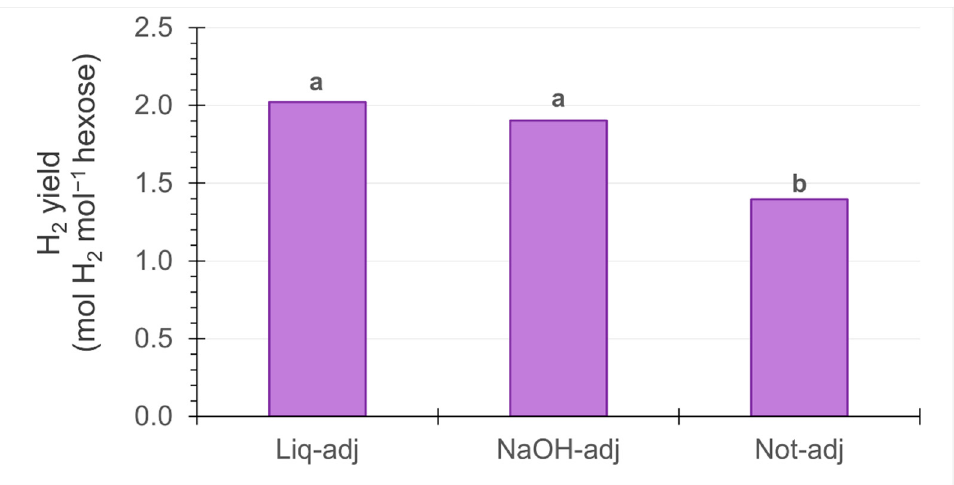
Figure 4. Cumulated H 2 production per mole of hexose from giant reed hydrolysates with different initial pH.; Liq-adj: black liquor-adjusted initial pH 8.7; NaOH-adj: NaOH-adjusted initial pH 8.7; Not-adj: not adjusted initial pH 5.3; Means with different letters differ significantly at p < 0.05 according to Tukey’s Honestly Significant Difference test.